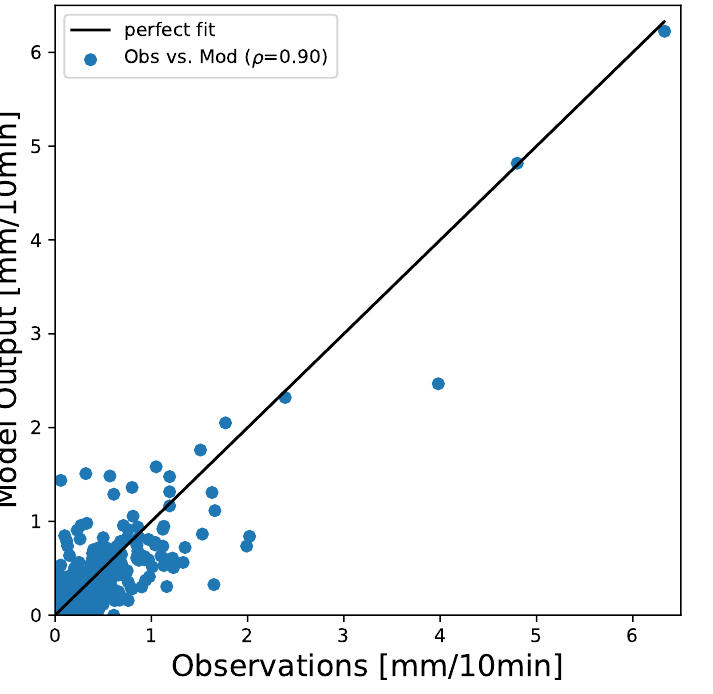
Figure 10. Scatter plot for observed (Obs) and modelled (Mod) precipitation (model run with best inputs) at location Hohenpeissenberg in 10-min resolution. Validation set (20% of the available data